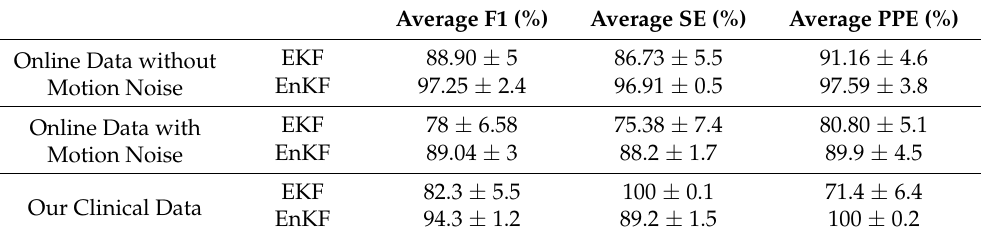
Figure 5. fECG extraction using the EKF and EnKF with the motion artifacts added PhysioNet data. The fQRS annotation is shown in orange asterisk (*). The red arrows show the places that fetal QRS was wrongly detected. The blue arrows show the missing fetal QRS. ( a ) Abdominal ECG (raw data); ( b ) fECG extracted using EKF; and ( c ) fECG extracted using EnKF. Table 1. Performance of the EKF and EnKF